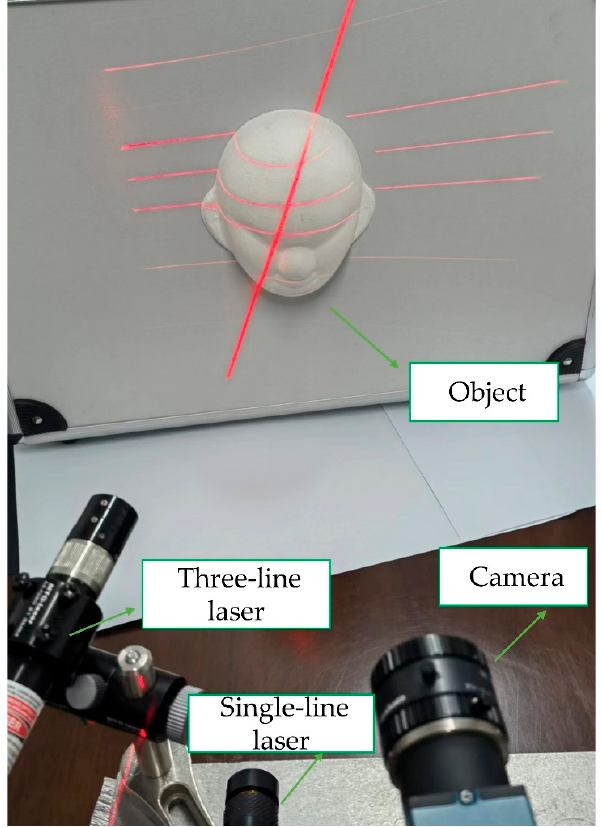
Figure 11. Measurement image of the face model.